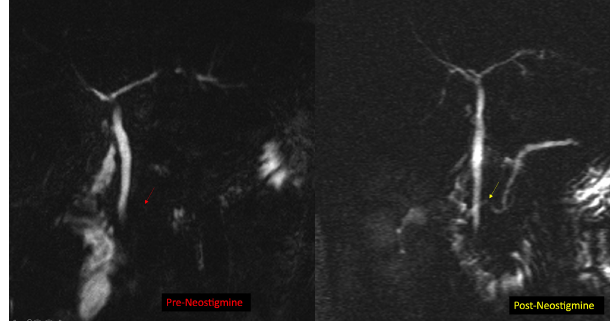
Figure 2. Coronal dynamic magnetic resonance cholangiopancreatograms were obtained before and 40 minutes after Neostigmine ® administration in a 33-year-old woman with a history of recurrent acute pancreatitis. In the baseline cholangiographic sequences, the Wirsung duct is not visualized (red arrow). Neostigmine ® allows the visualization of the main pancreatic duct (yellow arrow), crossing the choledochus and leading into the minor papilla. The short duct that drains the dorsal anlage of the pancreatic head, continues to be not visualized. These findings confirm pancreas